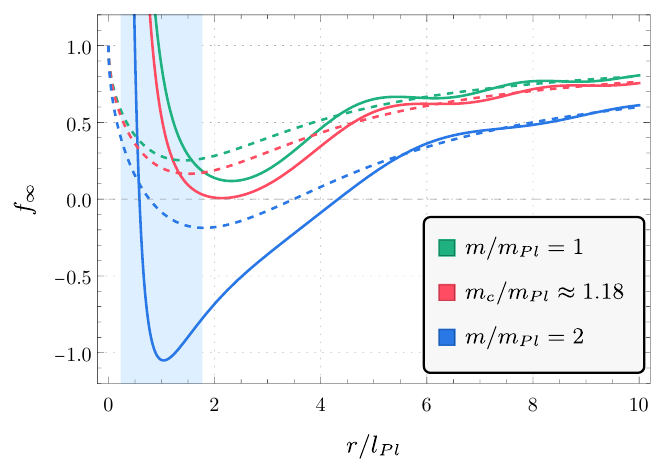
Figure 6 . Lapse function f ∞ of the final static configuration as a function of r for different masses, each depicted with a different color. The analytic solution based on the oscillating effective Newton coupling (5.6) with the function F ( r ) defined by (5.9) (dashed lines) is valid at large radii, r/l 1 . Pl (cid:29) In the deep UV instead, for r (cid:28) l , the lapse function is approximated by the analytic solution Pl to equation (5.2) (solid lines), and takes the value f (0) = 1 at the origin. The region highlighted ∞ in blue is where the transition between these two analytic solutions, which are valid in opposite asymptotic regimes, should